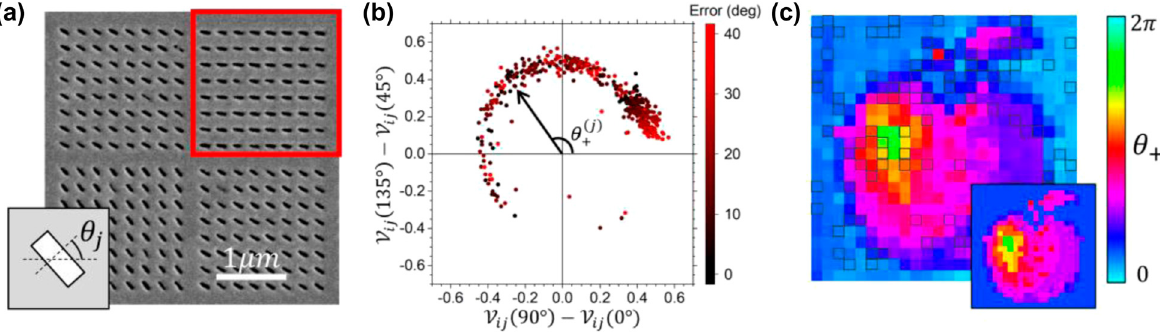
Figure 3: 1 degree of freedom coincidence imaging. (a) Zoom-in SEM image of the fabricated sample. Each pixel of the reference or object region (red square box) consists of an array of nano-slots with the same fixed orientations 𝜃 that control the polarization angle of j = 135 ◦ ) and D-pol ( 𝜃 = 45 ◦ ) plotted against the one transmitted light of the pixel. (b) The measured differential visibility between A-pol ( 𝜃 i i = 90 ◦ ) and H-pol ( 𝜃 = 0 ◦ ). The argument of the off-diagonal element of the Jones matrix 𝜃 ( j ) for V-pol ( 𝜃 + at object pixel j can be retrieved i i from the polar angle. The color of the data point corresponds to the error of retrieved results, taken as the smallest absolute difference between the target and retrieved 𝜃 ( j ) + . (c) Retrieved profile 𝜃 ( j ) + of the unknown object based on the differential visibilities. The lower-right inset is the target profile. The ‘‘noise’’ due to dead pixels (highlighted in open squares) from the camera is corrected by replacing them with the averaged value of the neighboring